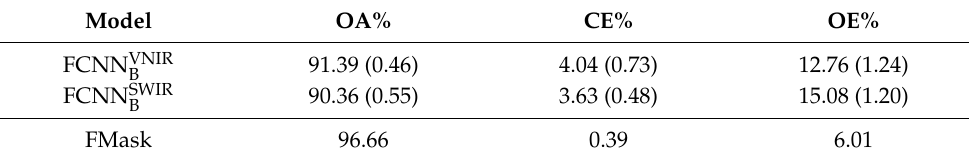
Table 5. Results of FCNN models and FMask evaluated on the L8-38Clouds dataset.